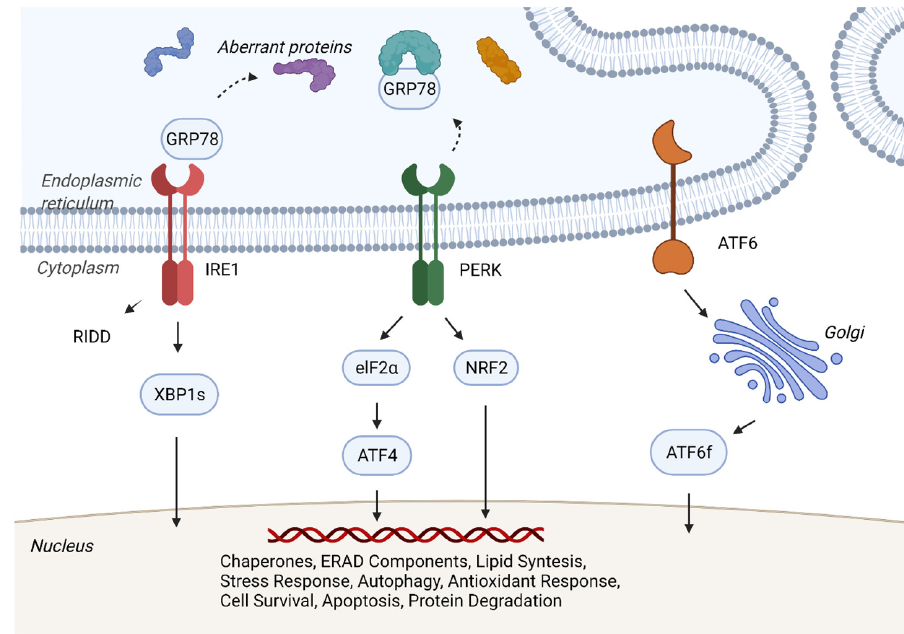
Figure 1. Unfolded Protein Response. A simplified version of unfolded protein response (UPR). Under stress, cells activate the adaptative UPR to establish cellular homeostasis and proteostasis. The sensors IRE1, PERK, and ATF6 are activated after the dissociation of GRP78, which is recruited due to the accumulation of misfolded and unfolded proteins. IRE1 oligomerization and auto ‐ phos ‐ phorylation induce kinase and RNase activity leading to mRNA degradation (RIDD) and altered splicing of the XBP1 mRNA and production of the transcription factor XBP1s. PERK undergoes oligomerization and auto-phosphorylation, subsequently phosphorylating the eukaryotic translation initiation factor eIF2 α , resulting in the translation of transcription factor ATF4. NRF2 is also phos ‐ phorylated by PERK and activates antioxidant responses. ATF6 activation occurs after transport to the Golgi apparatus where it undergoes S1P/S2P protease cleavage, yielding transcriptionally active ATF6f. The transcriptional events mediated by XBP1s, ATF4, and ATF6f promote the expression of chaperones and components of ER ‐ associated protein degradation (ERAD), reducing protein trans ‐ lation and increasing ER capacity in order to restore homeostasis. Additionally, UPR ‐ mediated gene expression also directly impacts autophagy, cytokine production, and apoptosis. Figure 1 was cre ‐ ated with BioRender.com.